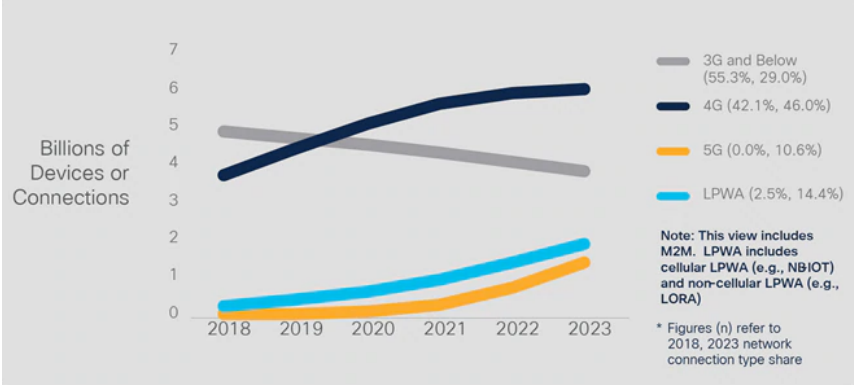
Figure 2. Global mobile average speeds by network type